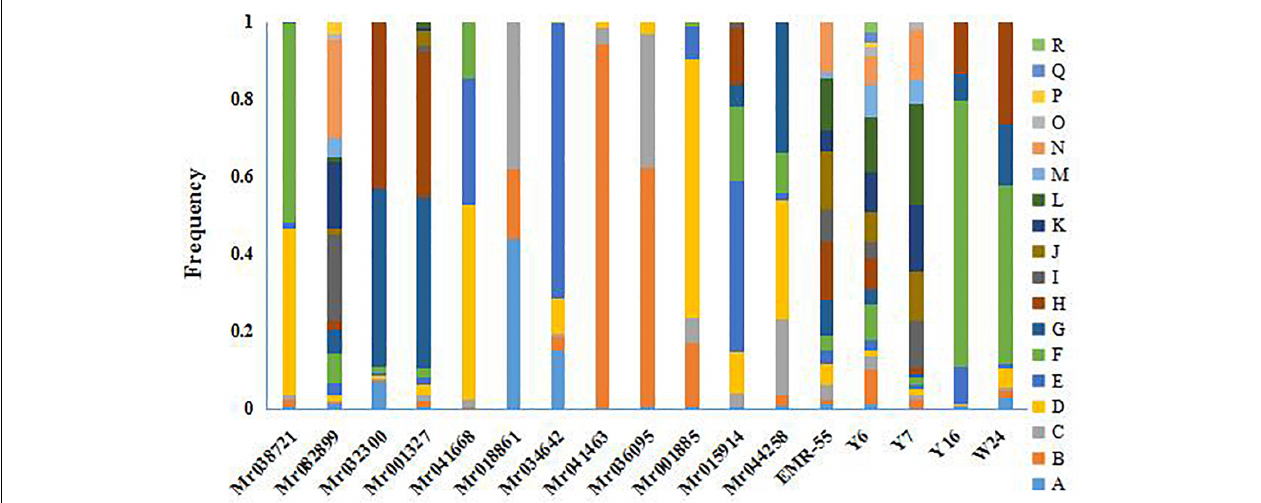
FIGURE 2 | Histograms presented frequency of alleles across loci in the seven populations of M. rosenbergii .